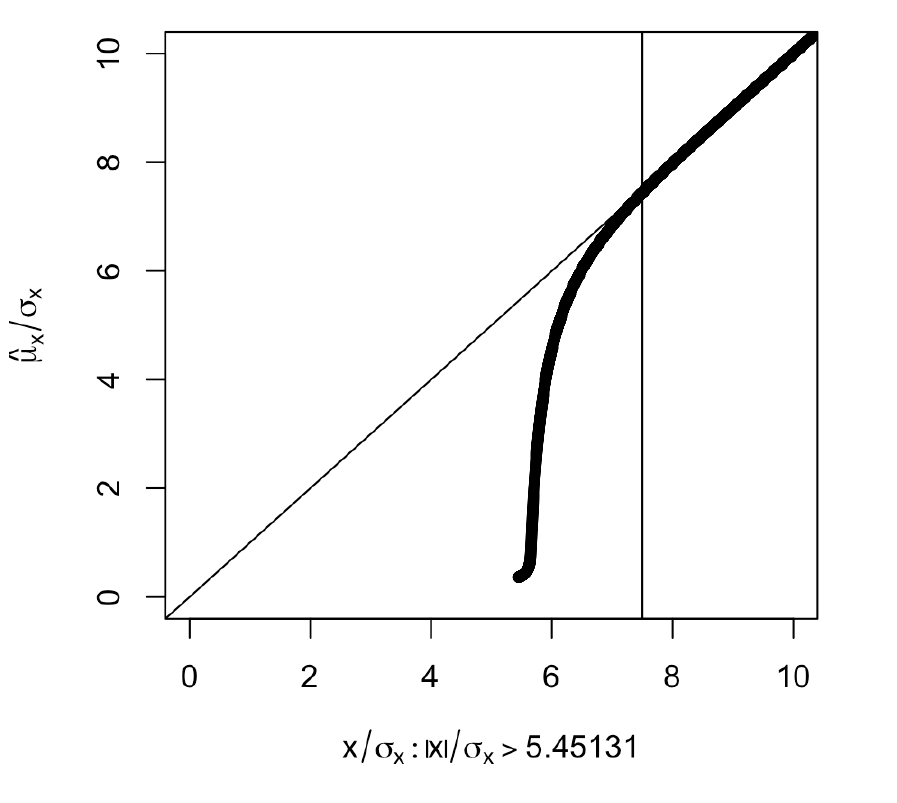
Figure 1. Plot of ˆ µ x / σ x against x / σ x selected under | x / σ x | > 5.45131 (corresponding to p < 5 × 10 − 8 ). The vertical line is at | x / σ x | = 7.5, which corresponds to a p -value of 6.38 × 10 − 14 . The part corresponding to x / σ x < 0 is not shown since ˆ µ x / σ x is an odd function of x / σ x